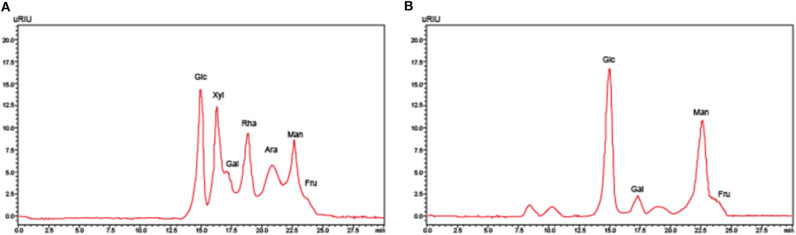
The high-performance liquid chromatography analysis of (A) monosaccharide standard sample and (B) EPS1-1 hydrolysate.